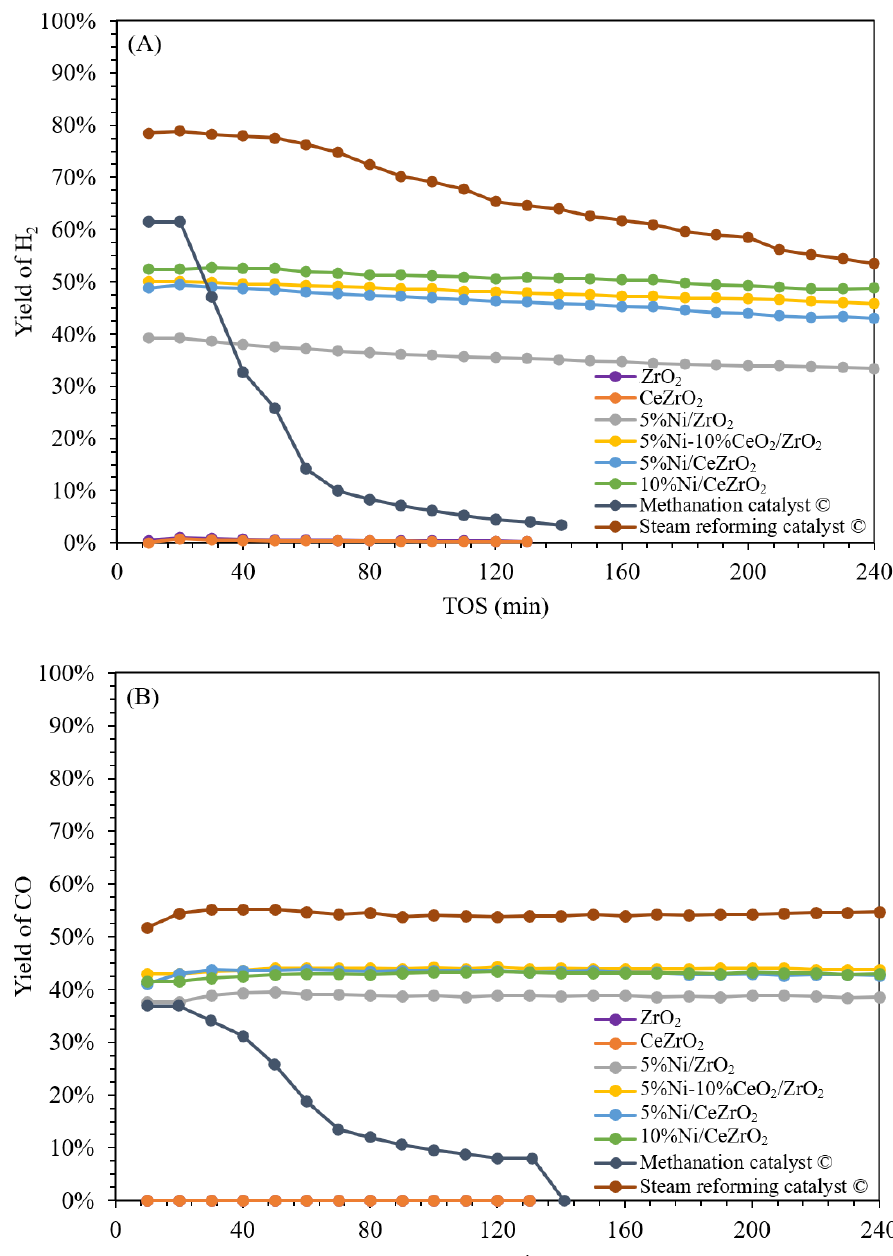
Figure 7. Yield of product on a ceria-zirconia-supported nickel catalyst: ( A ) H 2 and ( B ) CO (temper- ature of 700 °C, atmospheric pressure, WHSV 60,000 mL g −1 h −1 ). ture of 700 ◦ C, atmospheric pressure, WHSV 60,000 mL g − 1 h − 1